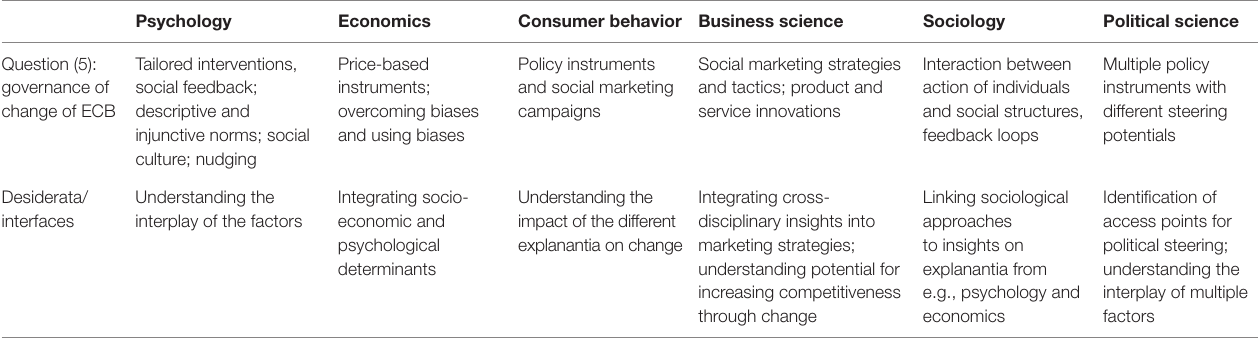
taBLe 3 | Governance in the foci of the different